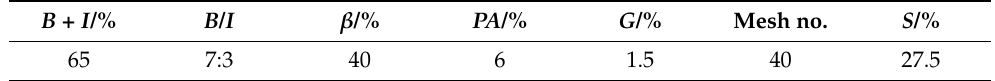
Table 6. Proportion of the similar material in the model test.